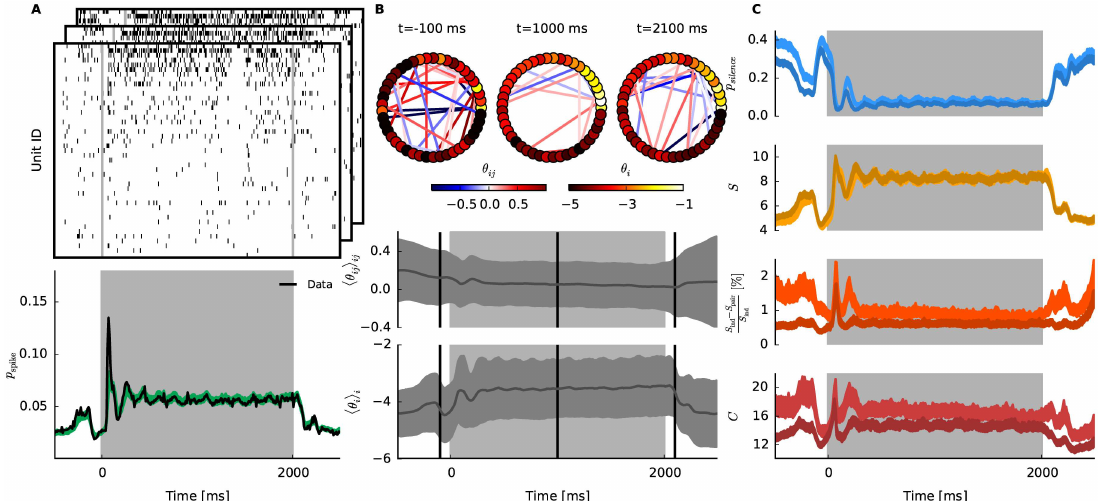
Fig 5. Dynamic network inference from monkey V4 data. In this experiment, a 90˚ grating on a screen was presented to the monkey for 2s (light gray shadedareas). 1004 trials were recorded, and binary spike trains were constructed with bin width of 10 ms. A Top: Exemplary spikingdata ( N = 45). Bottom: Empirical probability(black) of observinga spike over time and spike probability of the fitted model (green). B Top: The fitted network at three different time points, before, during, and after stimulation. Edges with significantly non-zero y t are displayed(as in Fig 1). Bottom: The mean of smoothedMAP estimates for ij y t and y t (dark gray line). The shaded area is the mean ± standard deviation. C Credibleintervals of macroscopicmeasuresof i ij the network over time obtainedfrom the smoothed estimates of the model (light color). Dark shaded area corresponds to the credible intervals of the estimates for trial shuffled data.